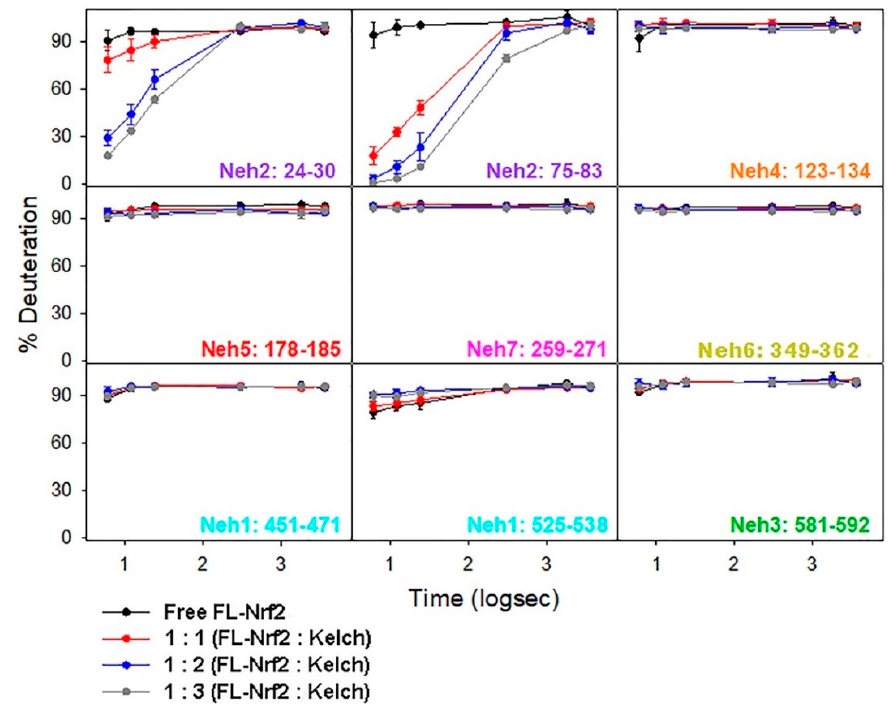
Figure 4. HDX-MS kinetic plots of free FL-Nrf2 (black) and in the presence of 1:1 (red). 1:2 (blue), and 1:3 (gray) molar ratios of